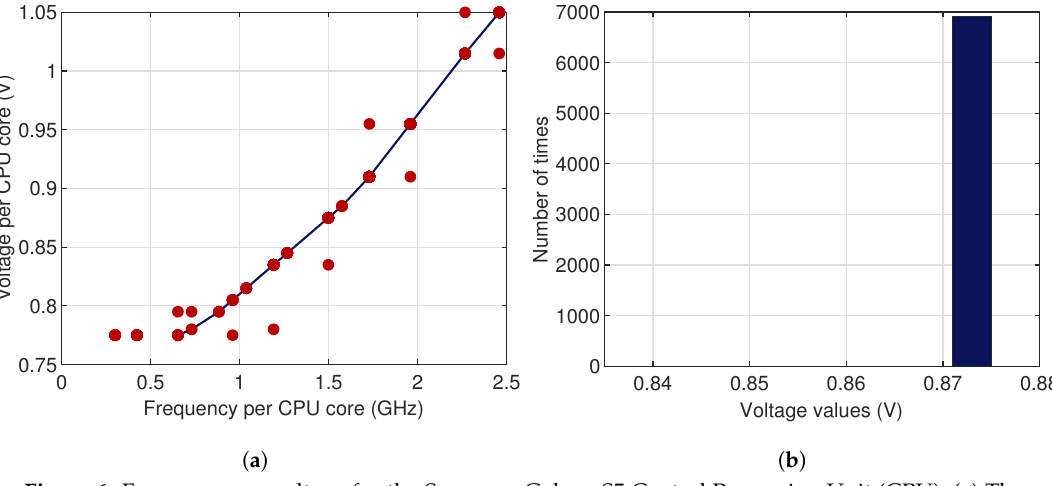
Figure 6. Frequency vs. voltage for the Samsung Galaxy S5 Central Processing Unit (CPU). ( a ) The voltage values drawn against the frequency values (in red), show a quasi-linear trend (in blue). ( b ) A histogram of voltage values for f =